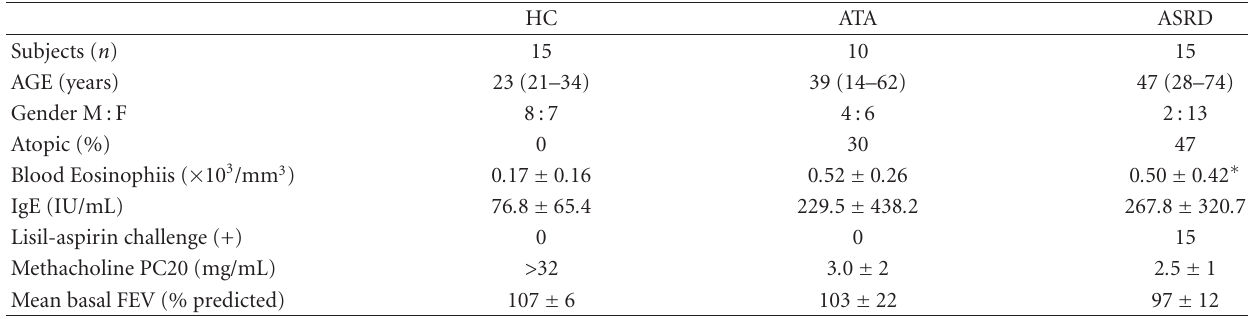
Table 1: Clinical characteristics of the study group.